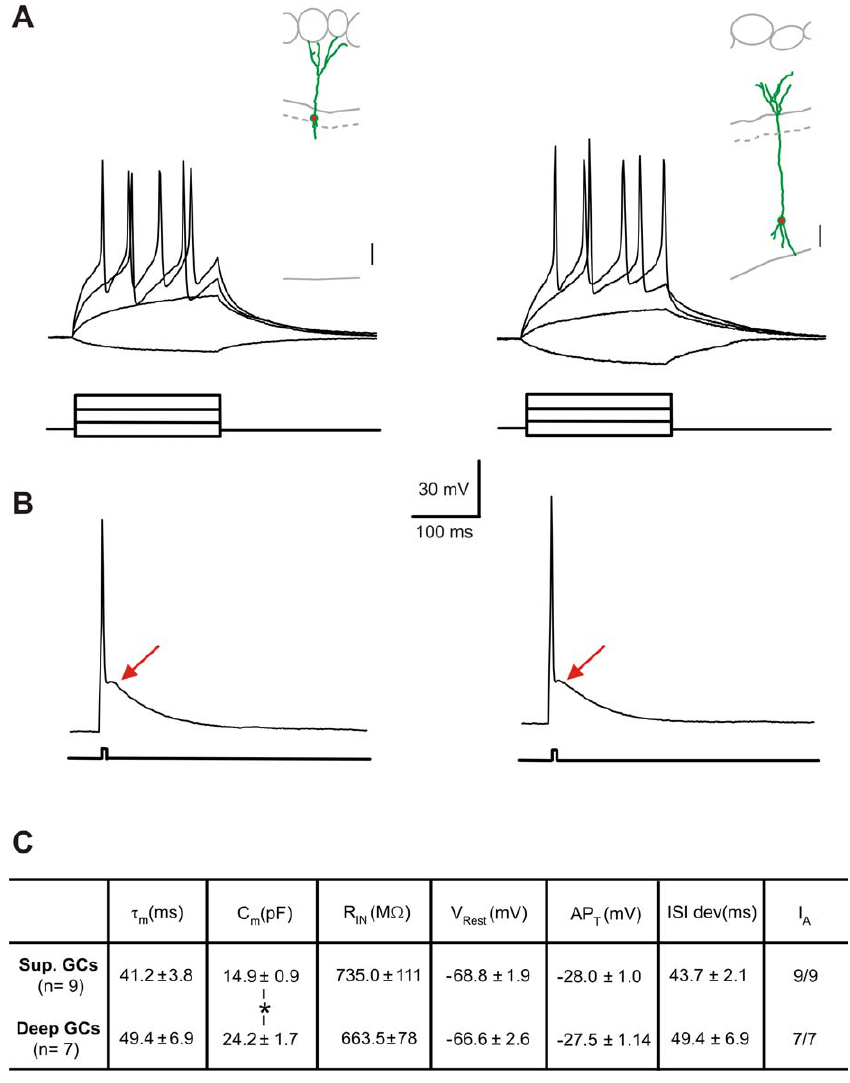
Figure 4. Deep and Superficial Dendritic Targeting GCs Intrinsic Somatic Electrical Properties (A) Targeted whole-cell recordings of GFP þ GCs (labeled either in the neonatal aSVZ or pSVZ) were performed (21–23 d.p.i.) and reconstructed after recordings. Both superficial (left panel) and deep (right panel) targeting GCs had a delayed firing pattern (200-ms current injection in 0.1-nA increments). (B) Both superficial (left panel) and deep (right panel) targeting GCs displayed an afterdepolarization current following a single spike (5-ms current injection in 0.4-nA increments). (C) The table summarizes passive and active membrane properties determined from superficial and deep targeting GCs. All determined parameters except membrane capacitance were similar for GCs with either deep or superficial dendritic targeting. s m is the membrane constant in milliseconds, C m the membrane capacitance in picofarads, R IN the input resistance in megaohms, V rest the resting membrane potential in millivolts, AP T the action potential threshold in millivolts, ISI, the interspike interval in millivolts, and I A is the I A